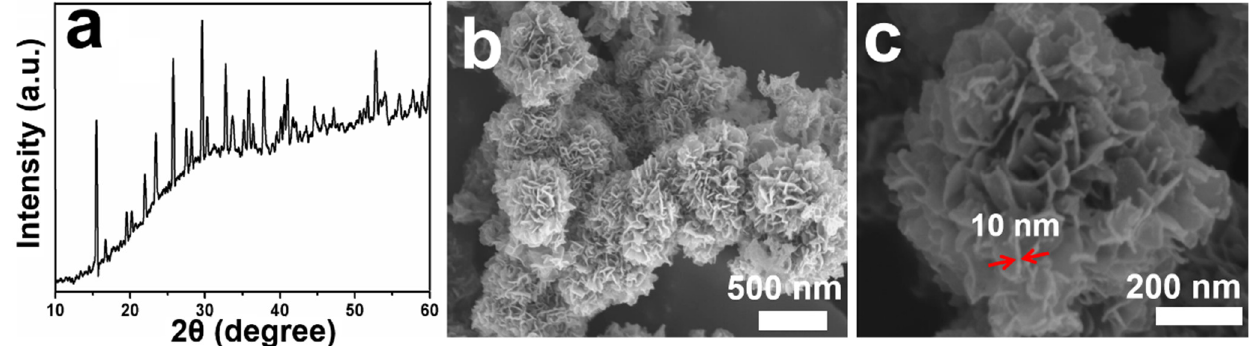
Figure 1. ( a ) XRD pattern, ( b,c ) FESEM images of the CoSeO 3 ‧ 2H 2 O nanoflowers.